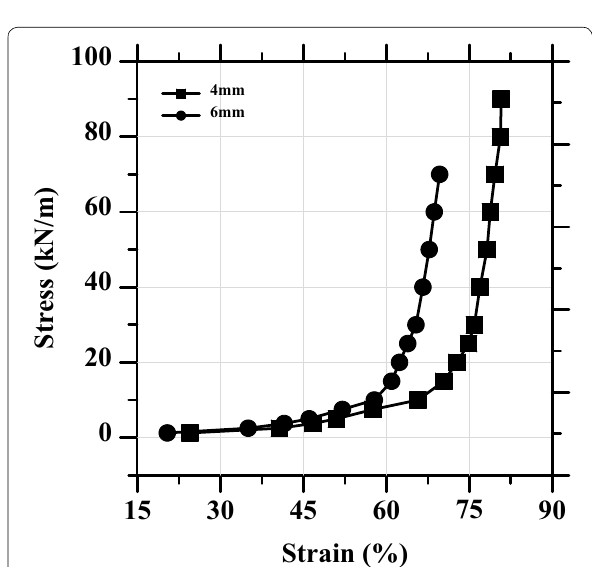
Fig. 10 Mean value of the compression test for two different sizes of the groove.